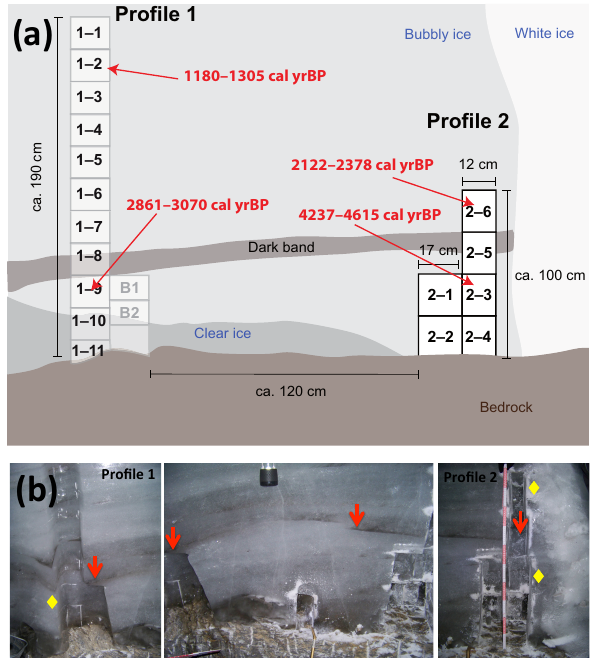
Figure 6. Calibrated radiocarbon ages of profiles 1 and 2 (in red, a ). (b) Collection of three pictures taken during the 2015 sampling campaign to illustrate the visual layering between profiles 1 and 2. The lower end of the visible dark band (indicated by red arrows) is located at about 41 and 63cm above bedrock for profile 1 and 2, respectively. Yellow diamonds indicate the location of radiocarbon- dated samples (see